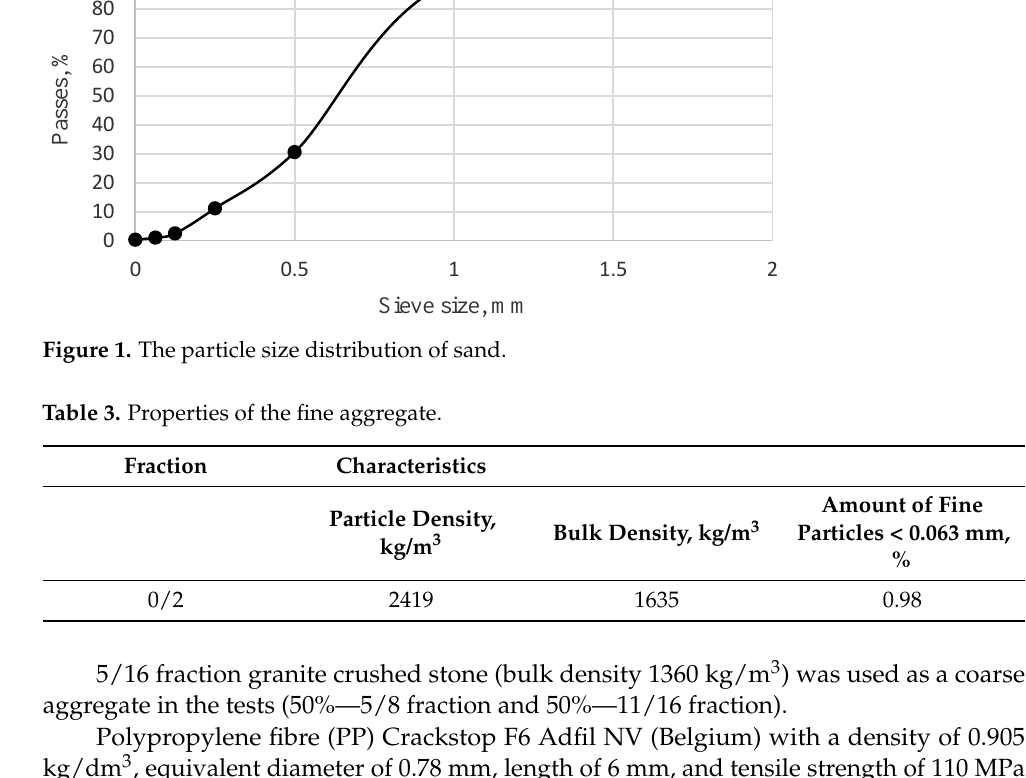
Table 4. Compositions of concrete mixes (kg/m 3 ).